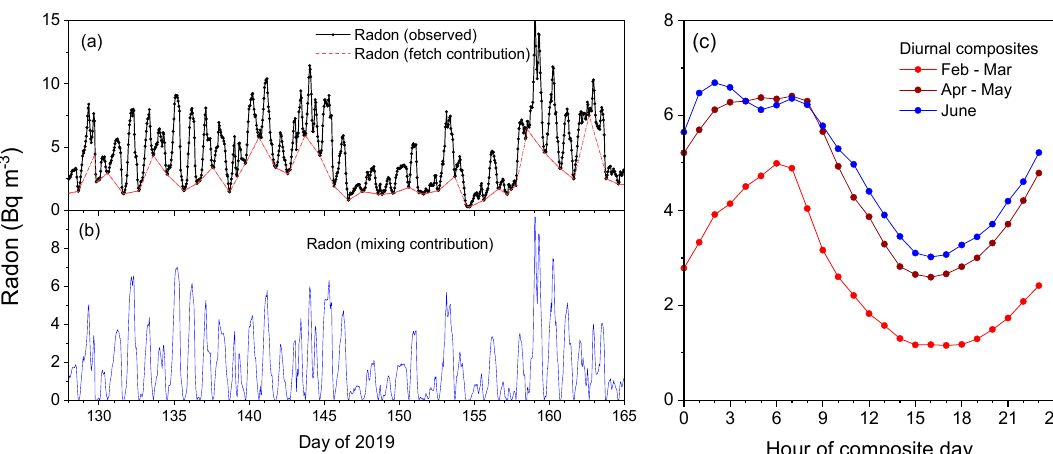
Figure 2. ( a ) A 5-week example of observed radon concentrations and the corresponding fetch-related contribution. ( b ) Mixing-related contribution to observed radon (observed—fetch), the x axis shows decimal days of 2019. ( c ) Diurnal composite radon concentrations for the hot (February–March), warm (April–May) and cold (June) months of the study.